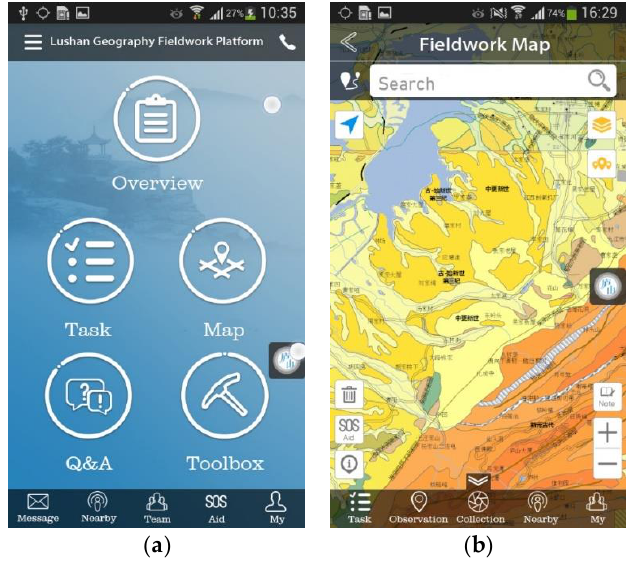
Figure 3. Student-side mobile application. ( a ) The homepage of the platform; ( b ) The page of fieldwork map.